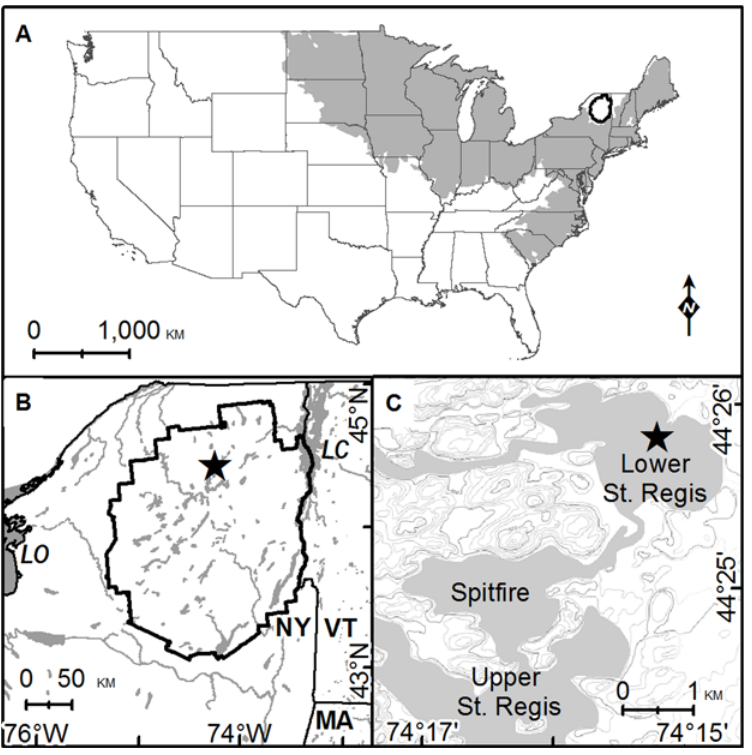
Fig 1. Site maps. A. Approximate range of yellow perch in the United States shown in gray (after reference 8). Note the prominent gap in northern New York, with the Adirondack Park boundary superimposed in bold. Scattered relict populations along the Florida coast (reference 33) not shown. B. The Adirondack State Park, NY. Lower Saint Regis Lake indicated by star. LC = Lake Champlain. LO = Lake Ontario. C. Saint Regis chain of lakes in Paul Smiths, NY. Coring site indicated by